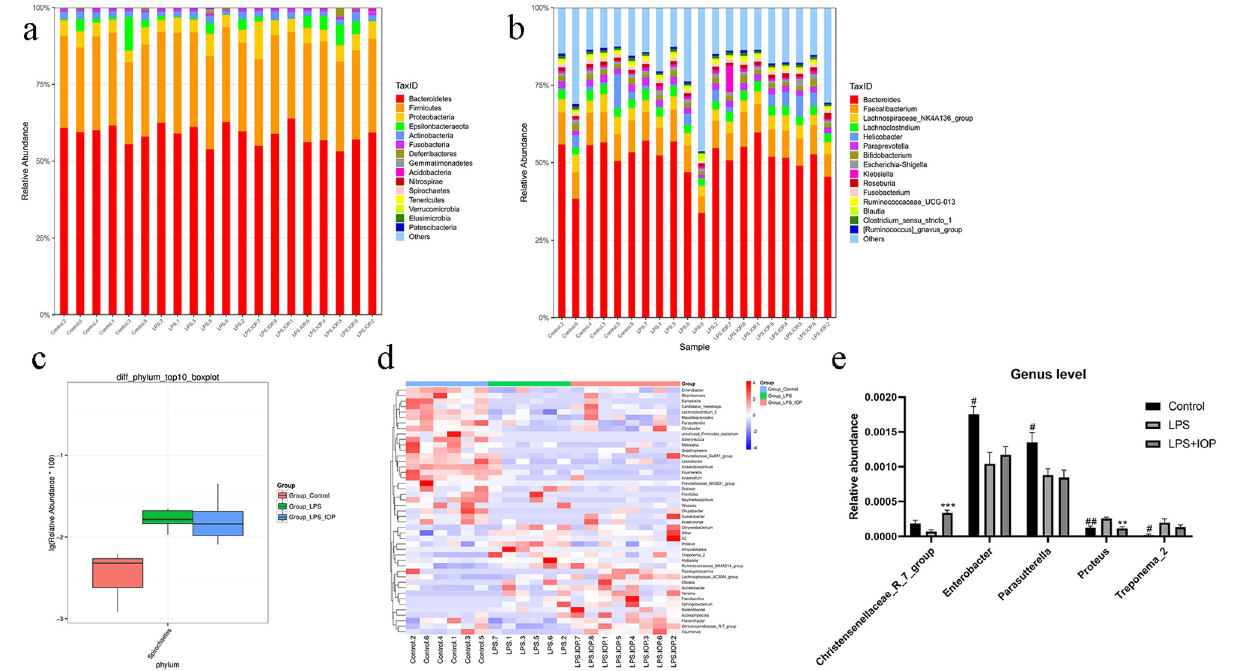
Fig 4. Changes in gut microbiota composition. (a). Species relative abundance of species at the phylum level. (b). Species relative abundance of species at the genus level. (c). Boxplot representing differences at the phylum level. (d). Heat map of differences at the genus level. Red indicates relatively high species abundance and blue indicates relatively low species abundance. (e). Significant species differences among the control group, LPS group and IOP interference group. # P < 0.05, ## P < 0.01,vs. Control group, �� P < 0.01, ��� P < 0.001vs. LPS group.